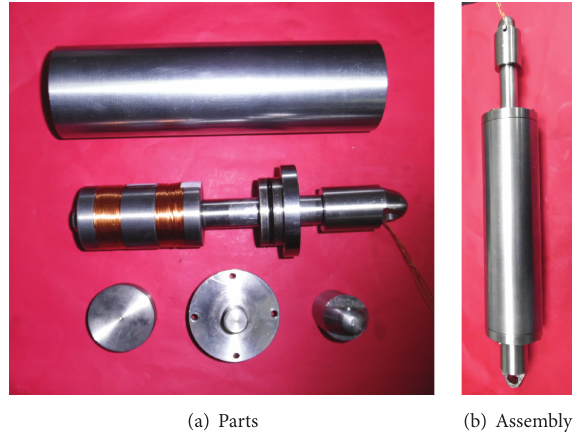
Figure 12: Prototype of the proposed double coil MR damper.